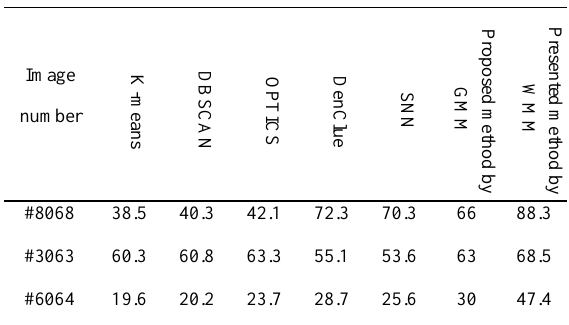
Table 3. Clustering accuracies (in %) of compared clustering methods on image clustering dataset.